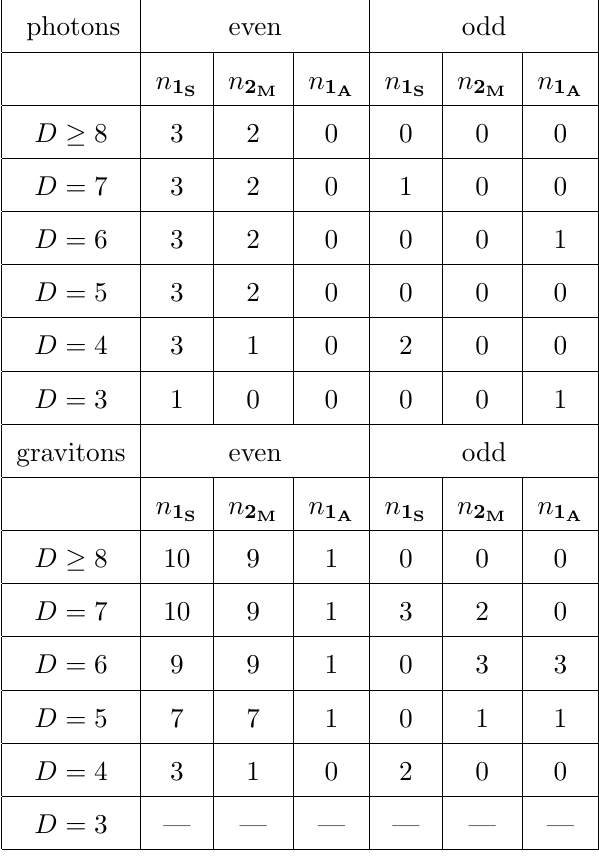
Table 4 . Number of parity even and parity odd index structures for 4-photon and 4-graviton S-matrix as various